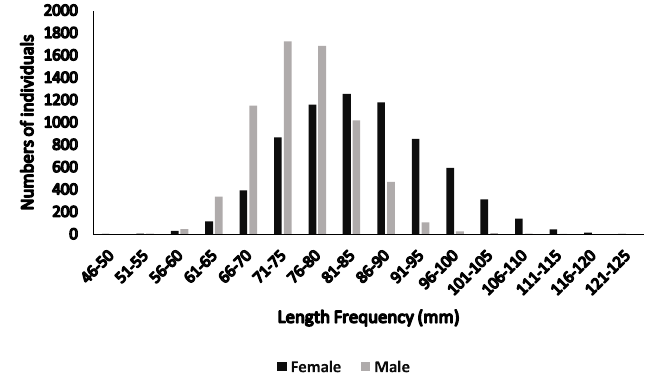
Fig. 2. Size frequency distribution of females and males of P. stylifera .